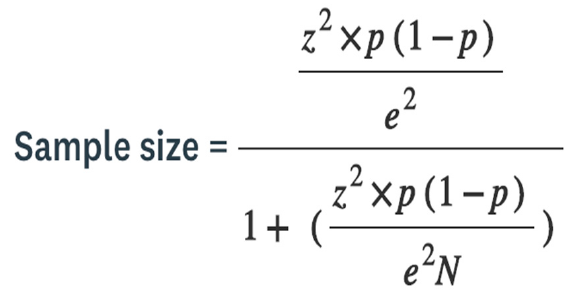
Figure 2. Sample size calculation equation.